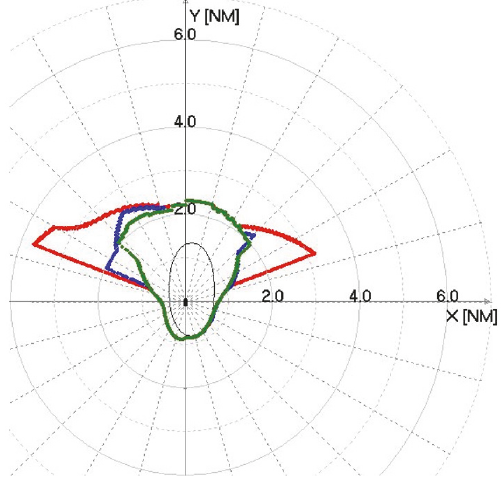
Figure 26: Action lines for stand-on encounterwith a target, whose true speed is 18 knots. Manoeuvres to both sides are considered, but they are limited by risk of resonance. Wind of 20 [m/s] and wave from 0 ∘ (green), 185 ∘ (blue), and 180 ∘ (red) are assumed.